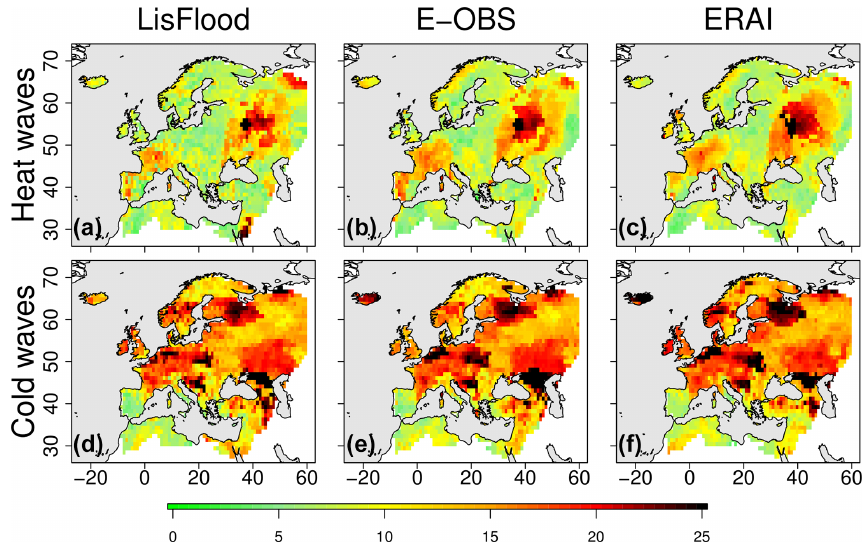
Figure 10. Same as Fig. 9 using the intensity based on the constant threshold (I3) for heat (a–c) and cold (d–f) waves, and based on LisFlood (a, d) , E-OBS (b, e) and ERAI (c, f)